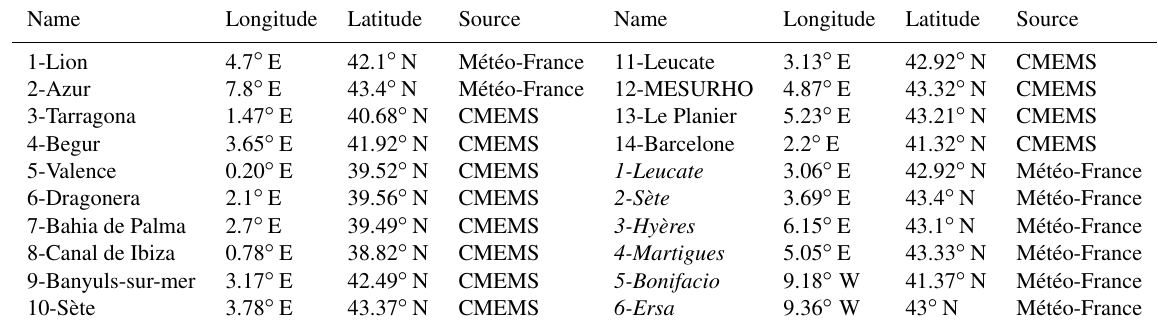
Table 1. Names and locations of the moored buoys and surface stations (in italics) used for validation. The numbers given in front of the names refer to Fig.